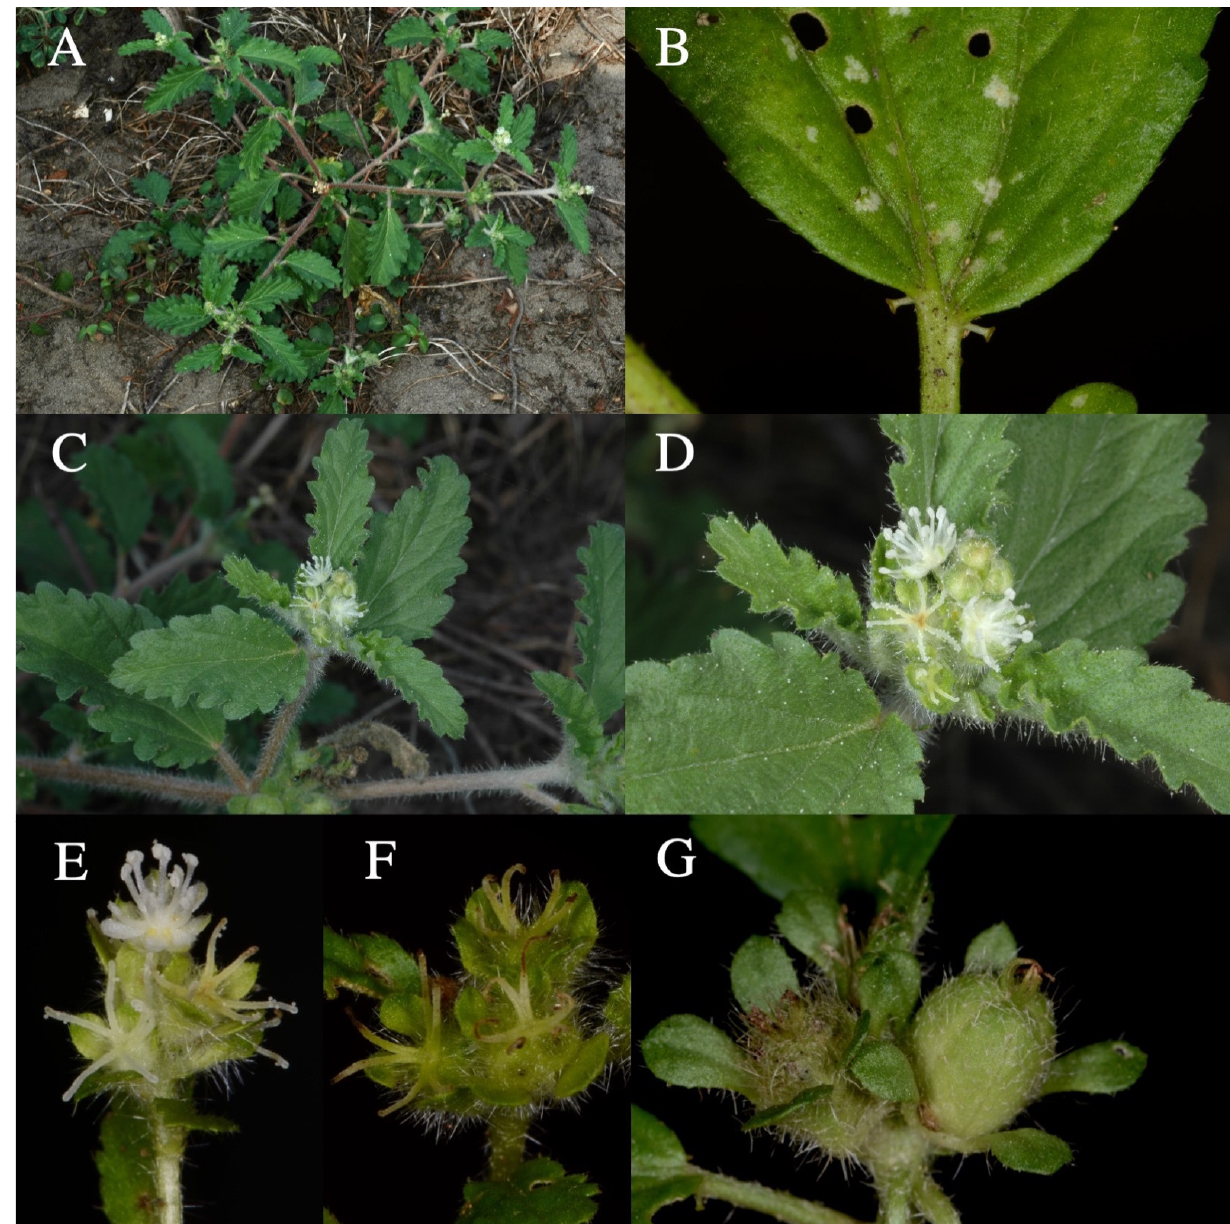
Figure A9. Croton glandulosus ( A ) Habit. ( B) Petiole and leaf base showing extrafloral nectaries. ( C , D ) Flowering branch tips. ( E ) Inflorescence. ( F ) Pistillate flowers. ( G )